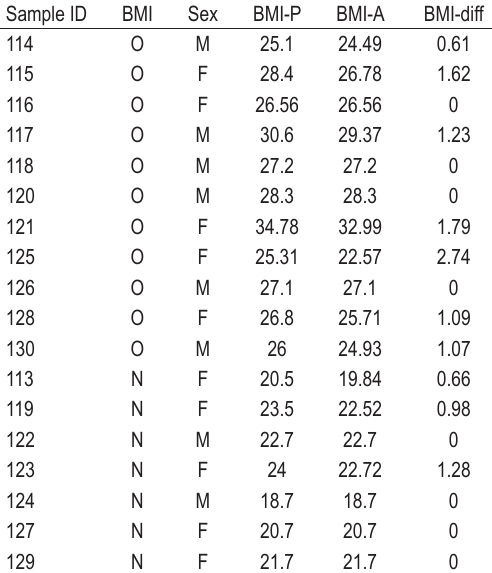
TABLE 3. BMI values before (BMI‑B) and after (BMI‑A) the implementation of personalized training and nutrition plan;